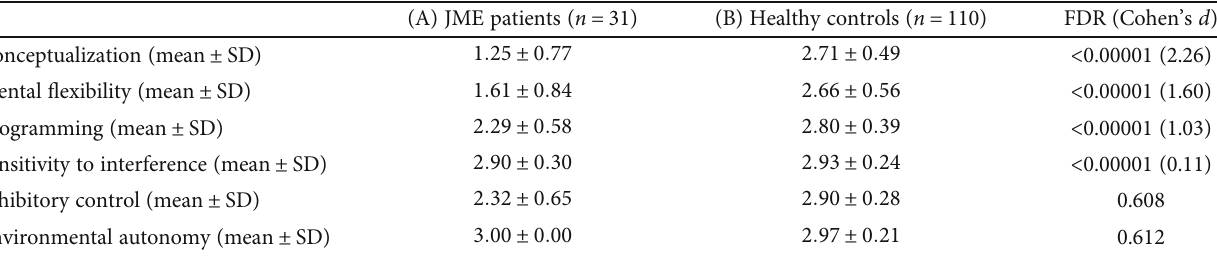
Table 2: Comparing FAB scores between patients and healthy controls controlling for age, sex, family history, disease duration, time from the last seizure, and multiple comparison.